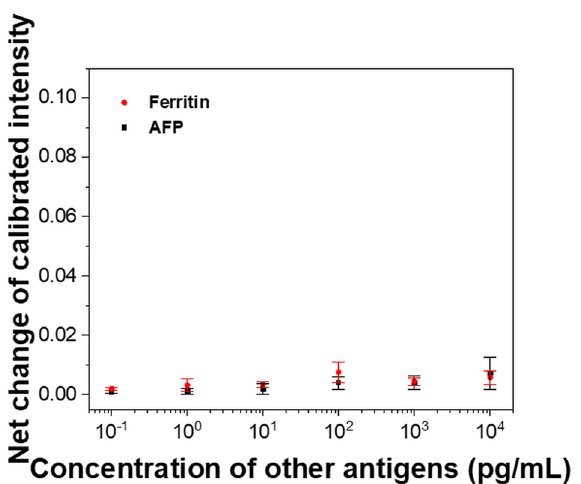
Figure 5. Selectivity of the FO LSPR sensor chip. Various levels of other antigens were measured by sensors fixed with Tg